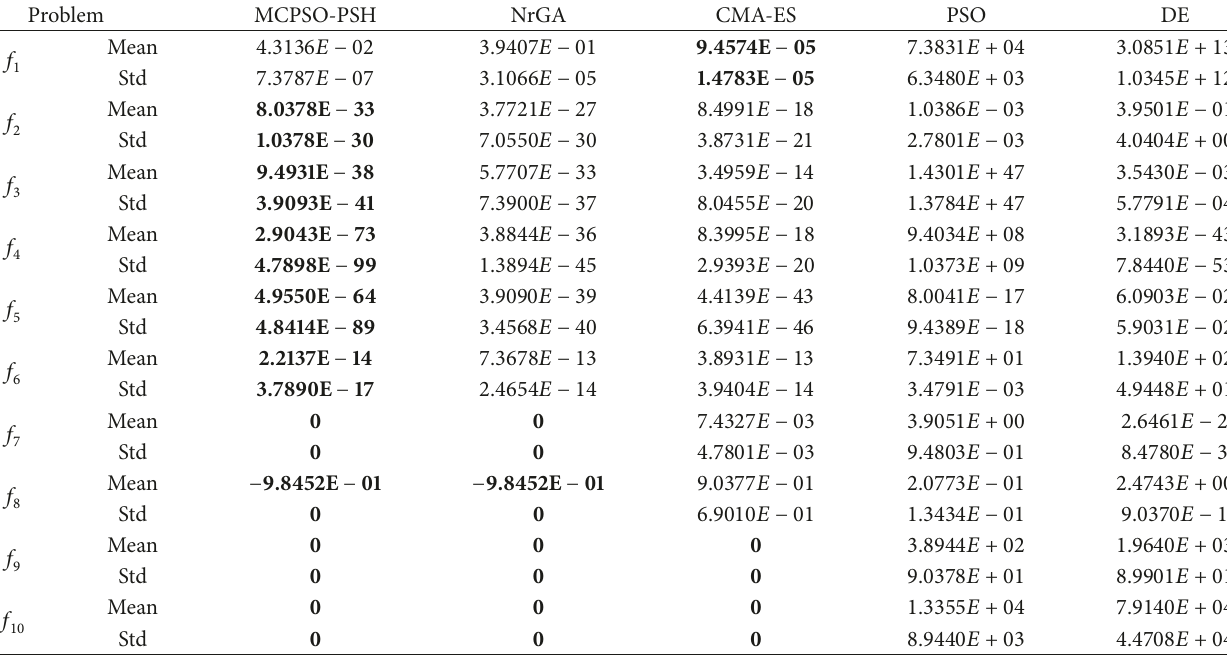
Table 1: Performance of all algorithms on 10D test functions 𝑓 1 – f 10